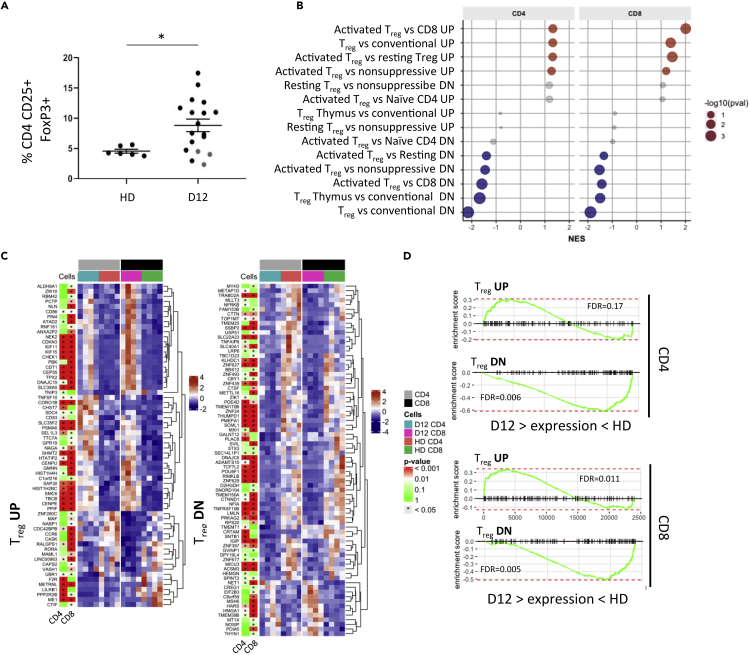
Lymphopenia-induced proliferation drives T cells toward a regulatory phenotype(A) Proportion of CD4+CD25 + CD127-FoxP3+ T cells in healthy donors (HD n = 6) and autograft patients at day 12 post-transplant (n = 18) (∗p = 0.023).(B) Gene set enrichment analysis (GSEA) of relevant published Treg signature gene sets. RNA sequencing was performed on FACS-sorted CD45RA-CCR7- CD4 and CD8 effector T cells of healthy donor (HD; n = 4) and day 12 post-autograft patients (D12; n = 4). Differential expression analysis performed for D12 vs HD on CD4 and CD8 effector T cell subset data separately. GSEA results show normalized enrichment score (NES) for selected gene sets and colored circles indicate significant enrichments toward genes upregulated (Red) or downregulated (blue) in CD4/CD8 effector T cells at D12 compared to HD.(C) Gene expression profiles of published signature genes (GSE22045 – genes UP/DN-regulated in Treg cells compared to conventional T cells) observed in FACS-sorted effector T cells at D12 compared to HD. Shown are genes from this gene set that are differentially expressed genes between D12 and HD in at least one cell type (CD4/CD8). p values are from differential expression analysis of D12 vs HD CD4/CD8 and are adjusted for multiple testing. Color key = standard deviation from the mean normalized expression level.(D) Barcode plots from gene set enrichment analysis of gene sets in C showing enrichments on the fold change expression ranking from D12 vs HD differential expression analysis.